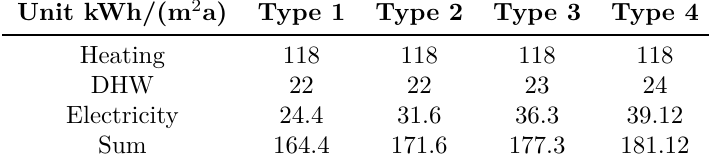
Table 6. Energy use in different housing